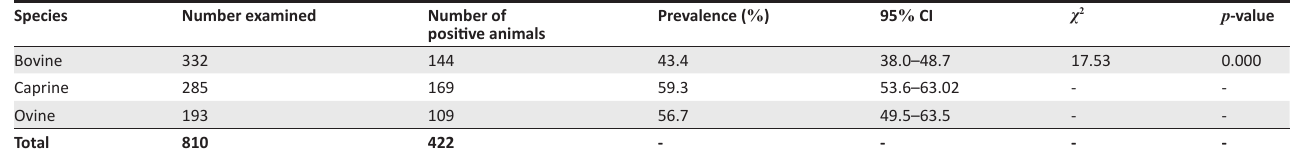
TABLE 1: Prevalence of foreign bodies in cattle, sheep and goats.